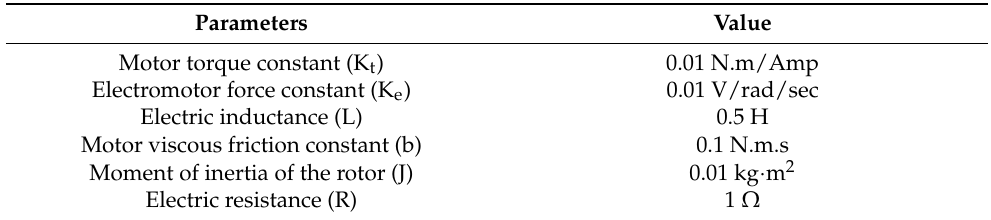
Table 1. The values of the DC motor’s parameters for fans, desiccant wheel, and water